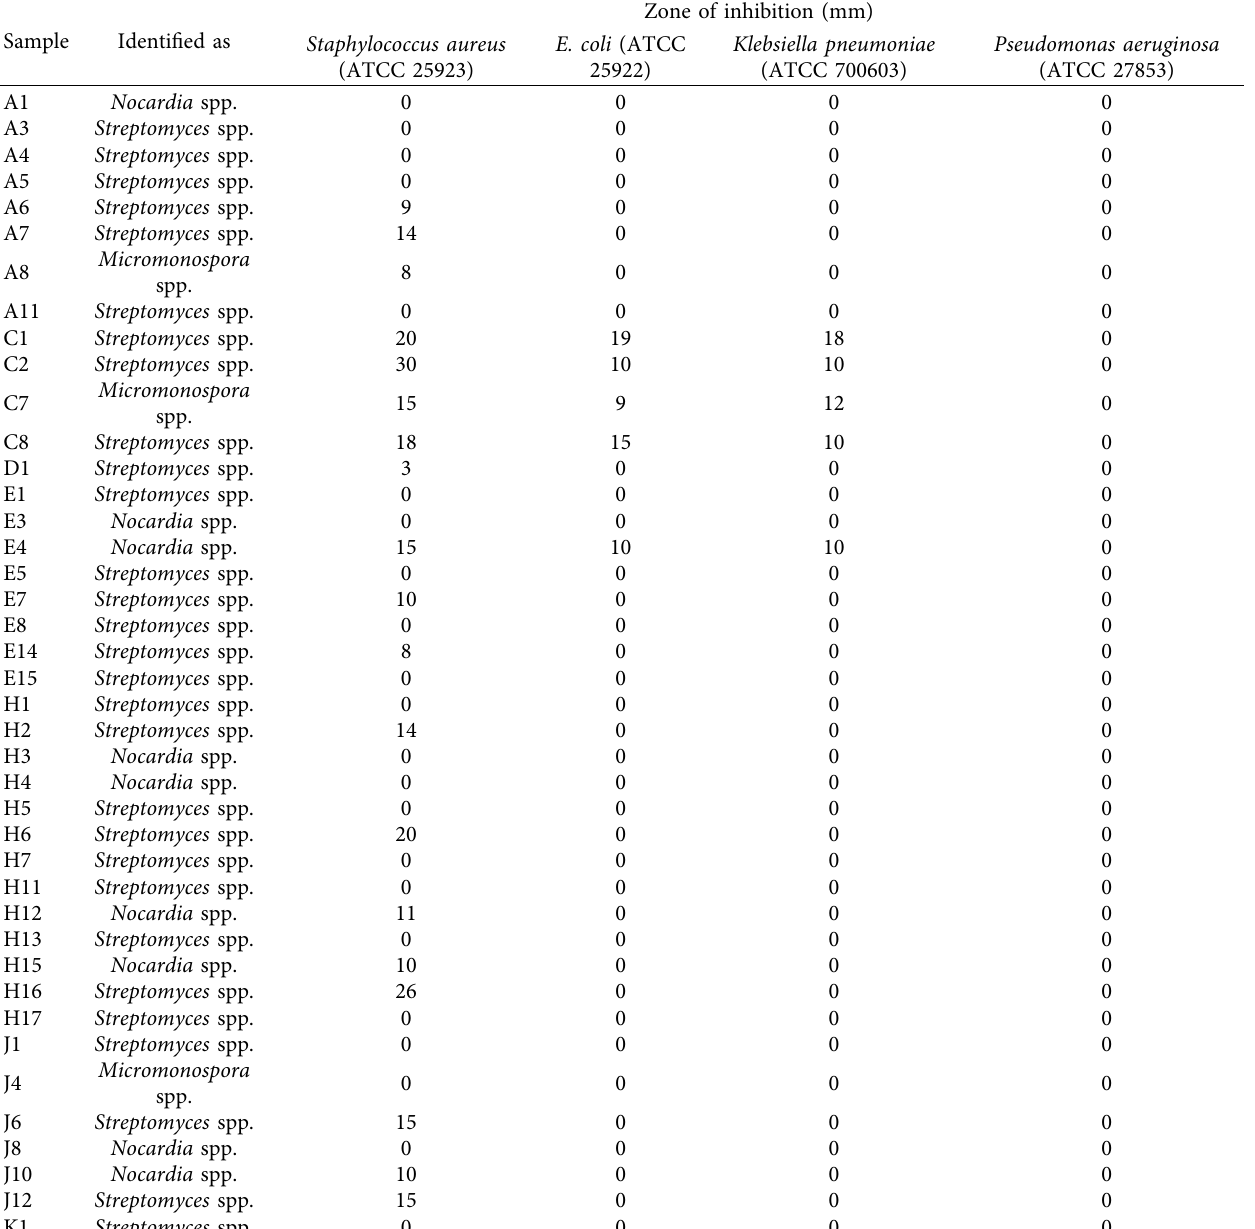
Table 3: Primary screening results of the